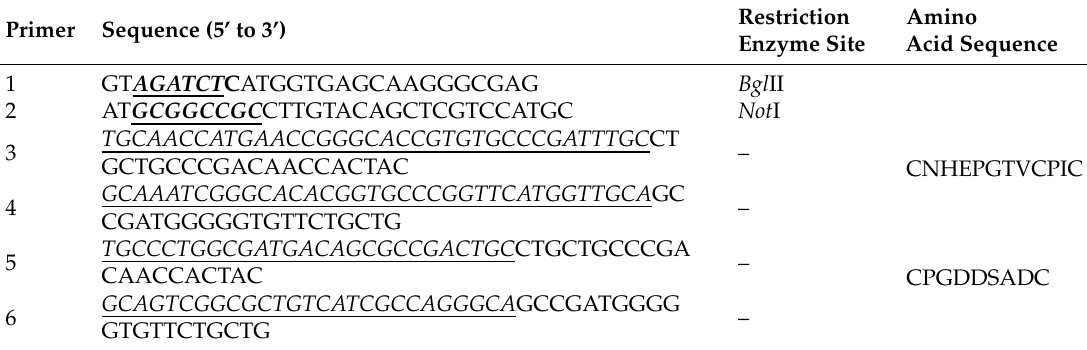
Table 1. The DNA sequences of the engineered eGFP with MBLs were confirmed by DNA sequencing. Table 1. Primers and amino acid sequences for MBLs used in this